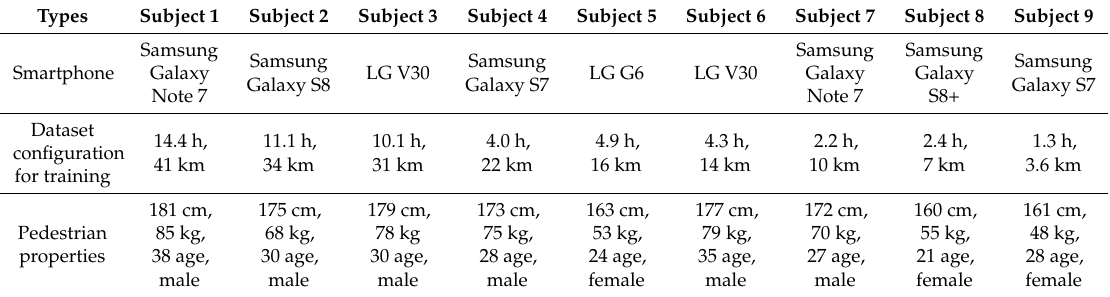
Table 4. Properties and Walking Dataset for Each